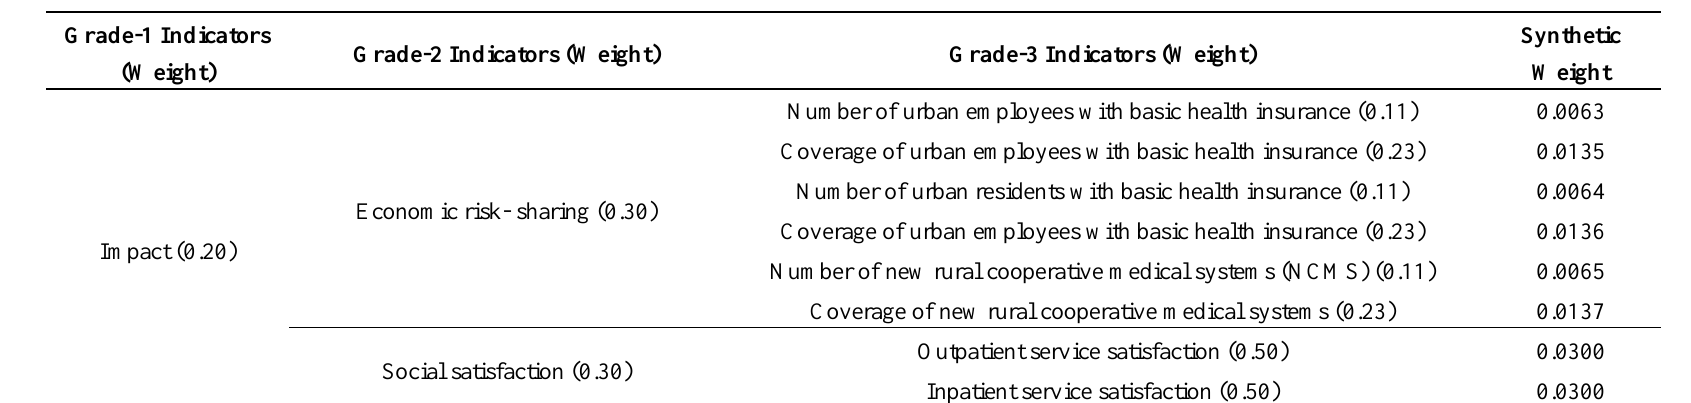
Table 4. Indicator system for health care (continued).